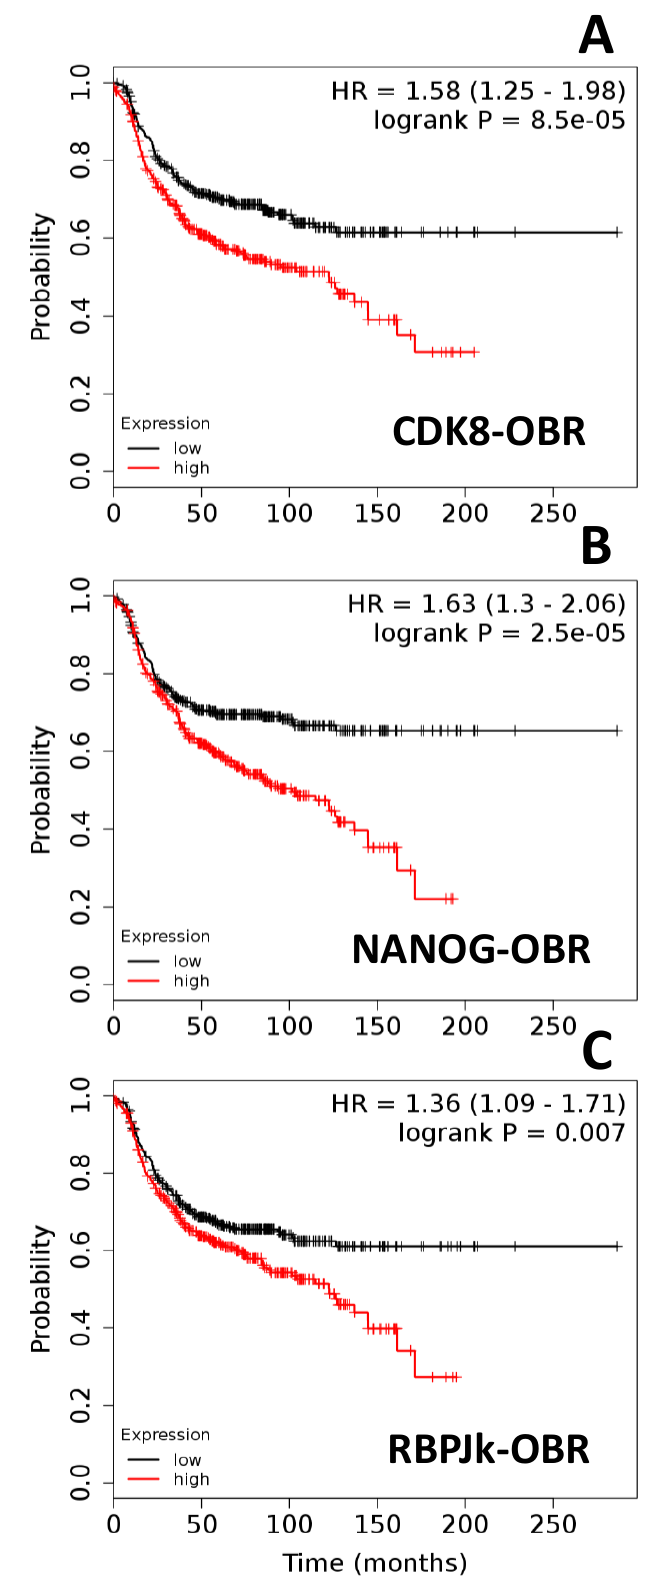
Figure 3. Co-expression of OBR and targeted genes decreases survival of ER negative breast cancer patients (BCER-). Survival curves of patients (n=801) with low and high expression of (A) CDK8-OBR, (B) NANOG-OBR and (C) RBPJk-OBR. Kaplan-Meier survival plots were calculated using data from the Cancer Genome Atlas (TCGA). Graphs depict relapse free survival. Patients surviving beyond the timeline threshold (20 years and 10 months) were censored instead of excluded. Hazard ratio (HR) range and P values (logrank P) were obtained for the BCER- patients using Kmplot.com software [46].